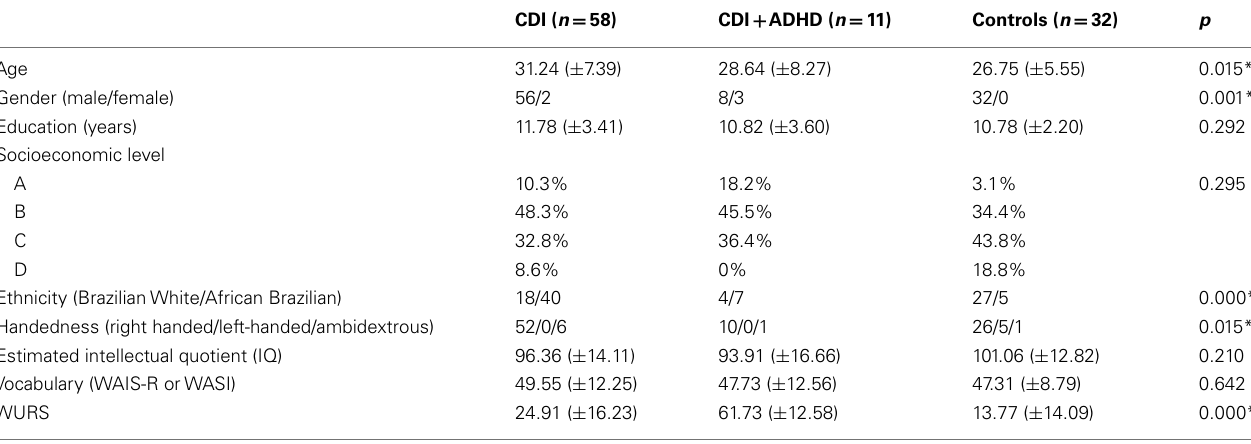
Table 1 | Socio-demographic variables, intellectual functioning, and substance use of the CDI, CDI + ADHD, and healthy